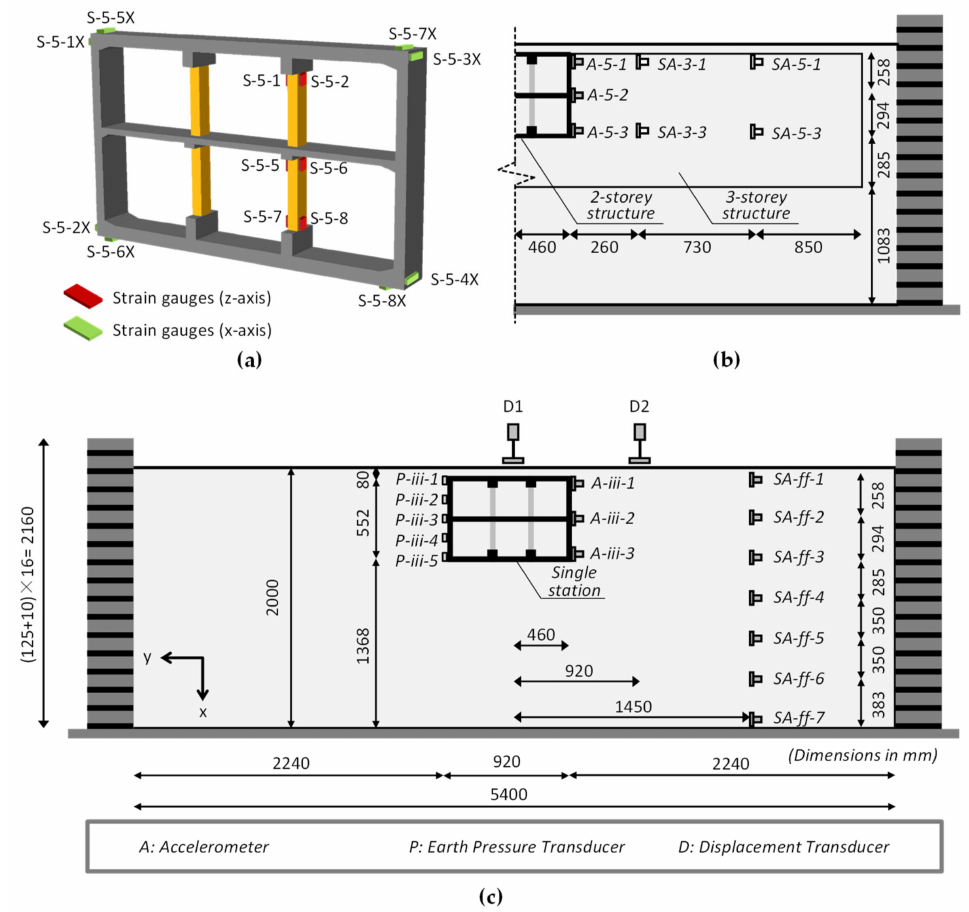
Figure 7. Instrumentations of ( a ) the strain gauges on the structure, ( b ) the sensors in section 3 and ( c ) the sensors in section iii, with units expressed in